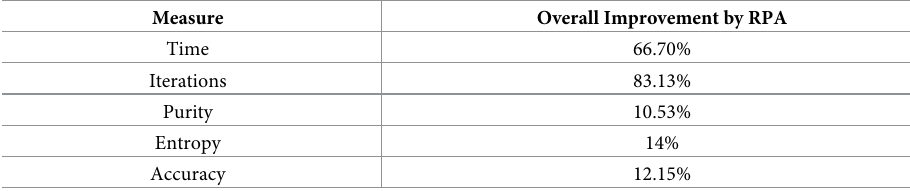
Table 19. Overall percentage improvement by RPA